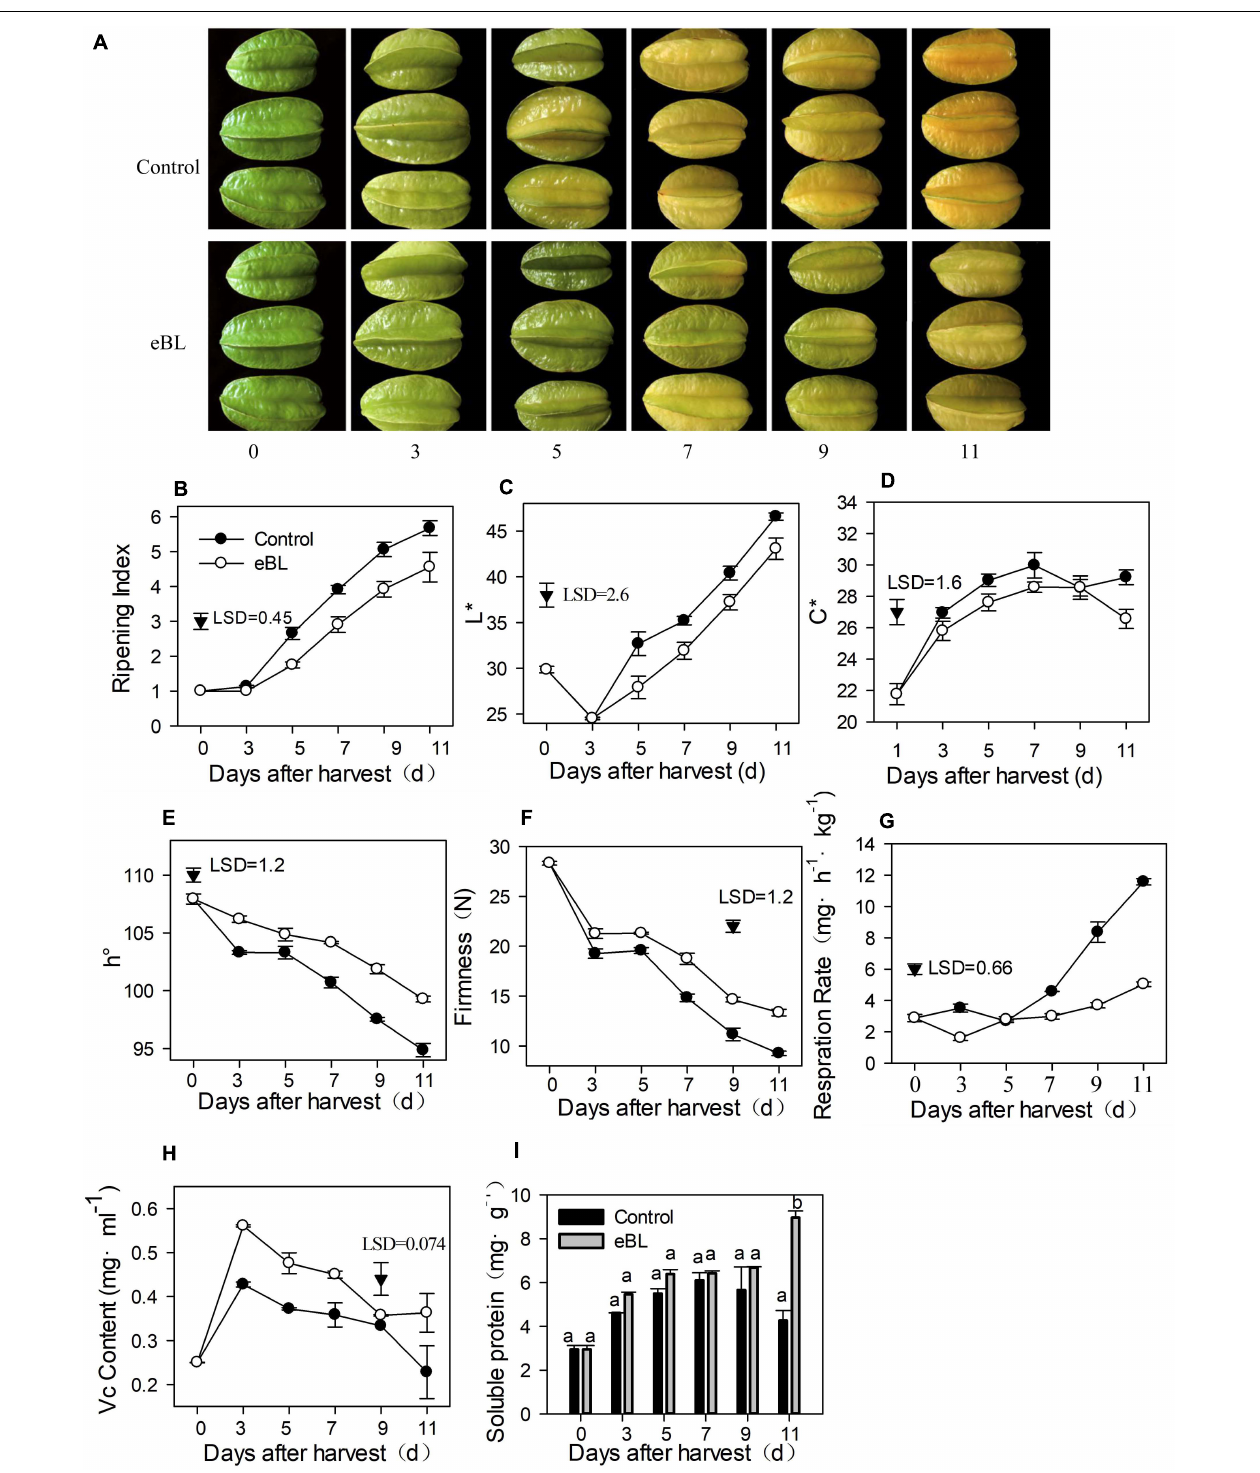
FIGURE 2 | The effects of 2,4-epibrassinolide (eBL) on carambola fruit ripening. (A) Photos of carambola fruit treated with or without eBL; (B) fruit ripening index assessment; (C–E) fruit color changes in L * value (C) , C * value (D) , and h ◦ value (E) ; (F) fruit firmness changes; (G) fruit respiration rate; (H,I) the content of Vc (H) and soluble protein (I) . Carambola fruit were stored at room temperature (25 ± 1 ◦ C) after treatment. Least significant differences (LSDs) were calculated to compare significant effects at the 5% level. Each data point represents the mean ± S.E. ( n = 3). Means within a column among different groups followed by the same letter are not significantly different at the 5%